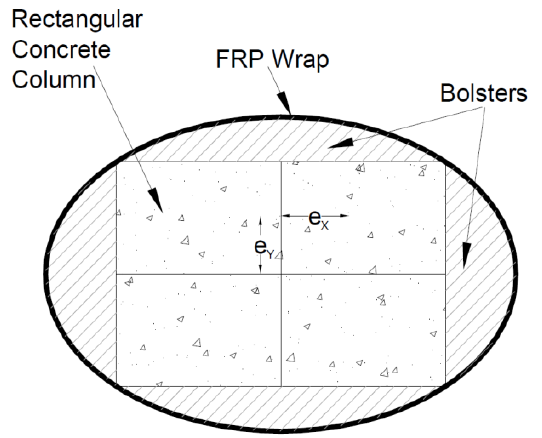
Figure 3. Shape modification of rectangular column with bolsters to increase FRP confinement